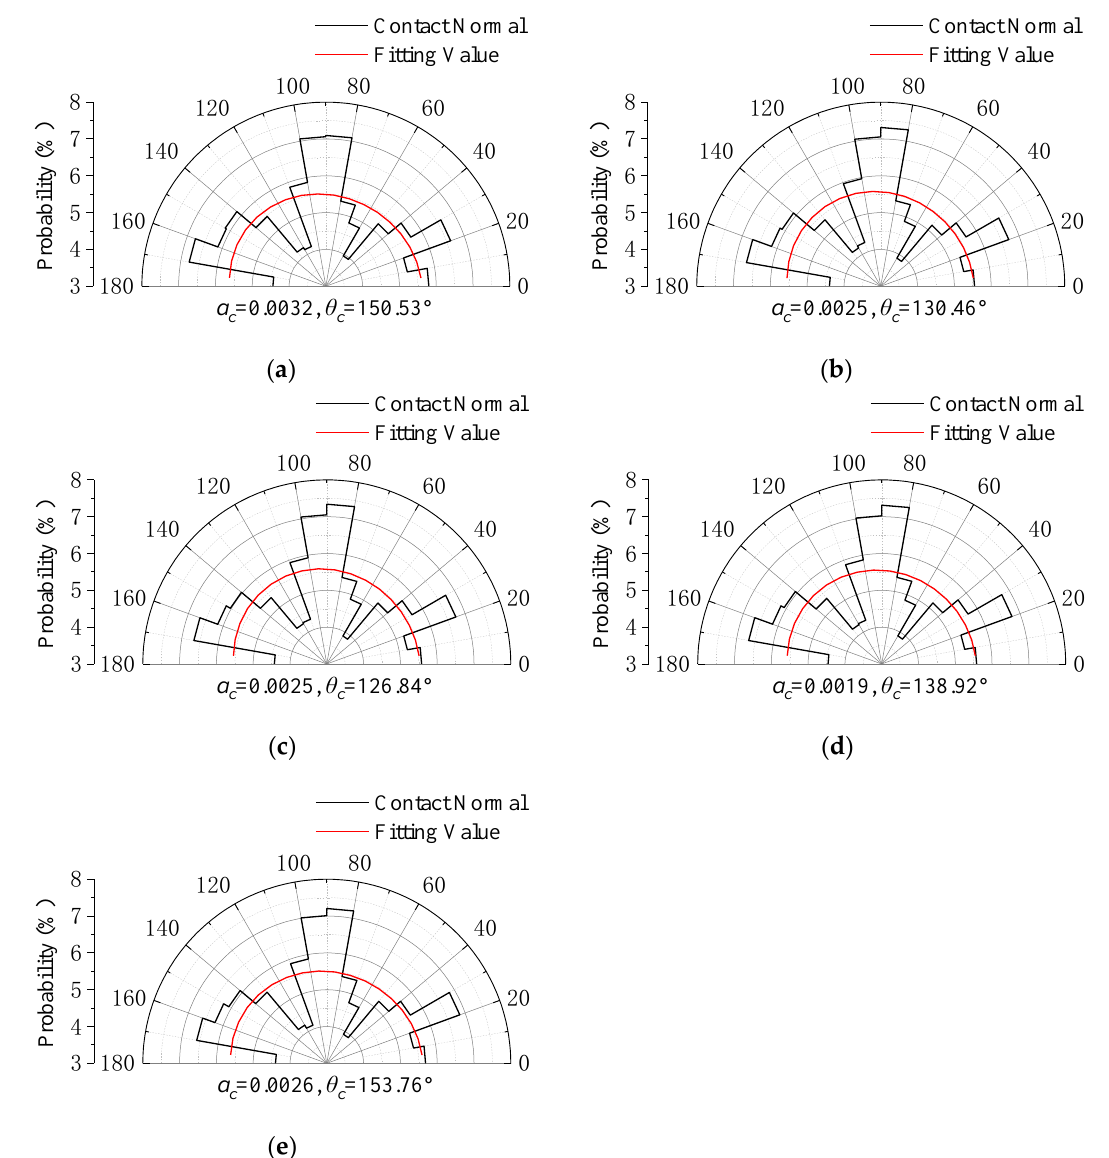
Figure 9. Gradual development of anisotropy: ( a ) initial state A; ( b ) intermediate state B; ( c ) peaking state C; ( d ) resilient process D; and ( e ) final state E.